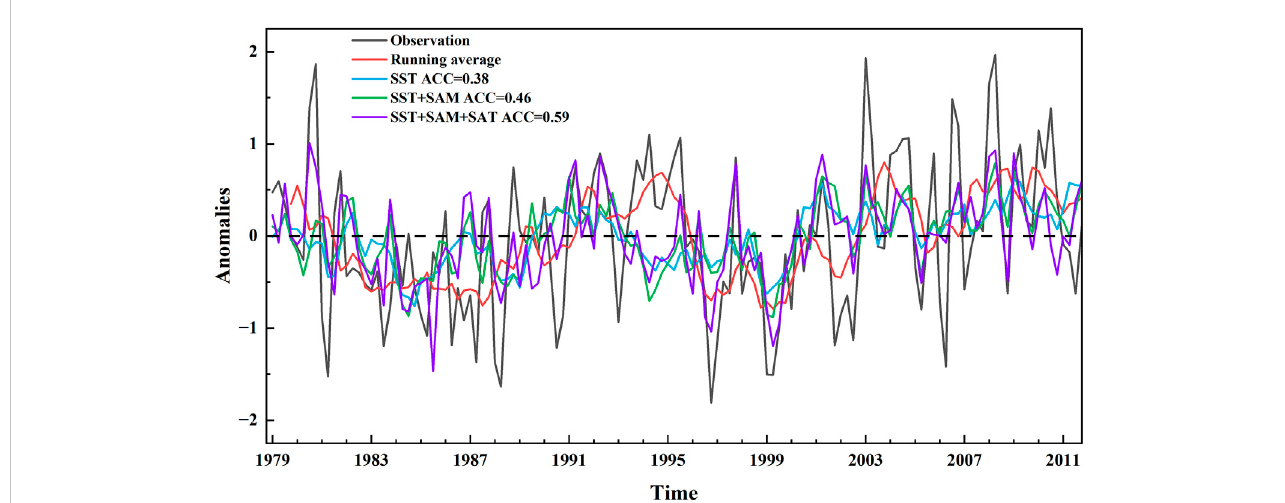
FIGURE 6 Weddell Sea SIC anomaly observation, seven-season running average of observation, and simulation by multivariate linear regression equations using three groups of predictors shown in Formulas 6, 7, and 8 in fi tting period (unit: %). ACCs of those three models are indicated on the panel ’ s left.